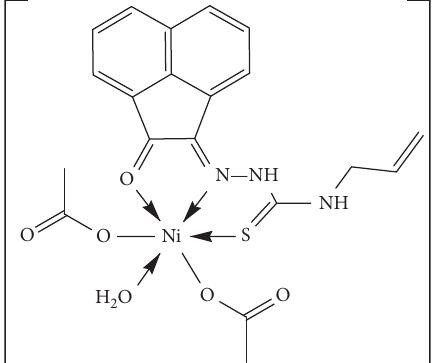
Figure 3: Suggested structure of Ni(II) complex.